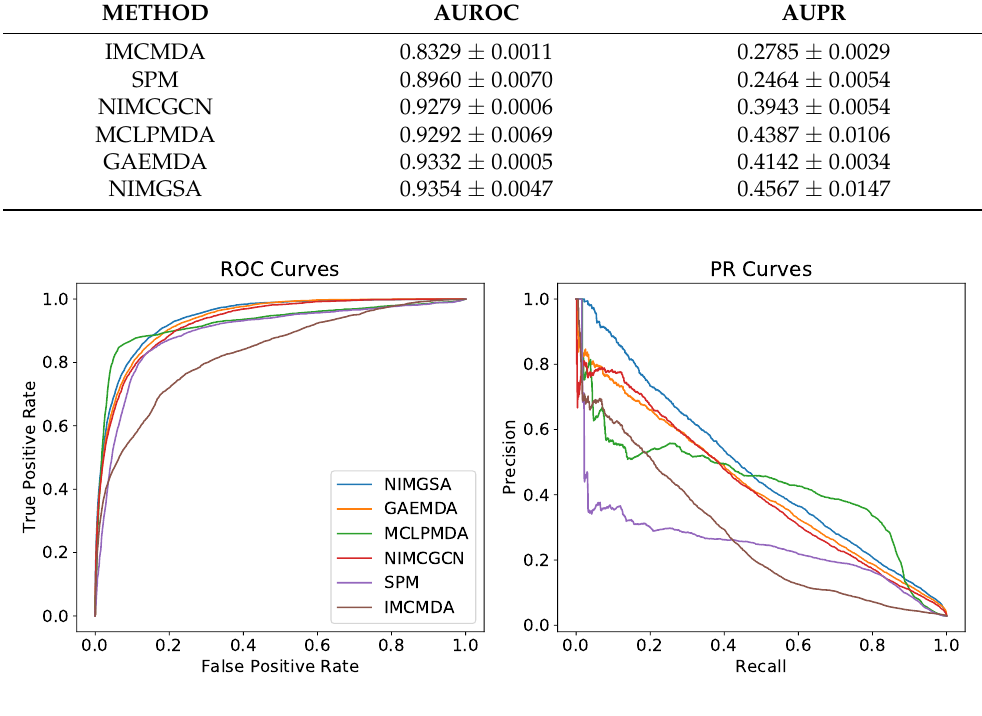
Figure 4. ROC and PR curves of different methods. Table 2. Binary classification metrics of different methods on Dataset2. Sp denotes specificity. Sn denotes sensitivity. Acc denotes accuracy. Pre denotes precision. F1 denotes F1-score. Mcc denotes Matthews correlation